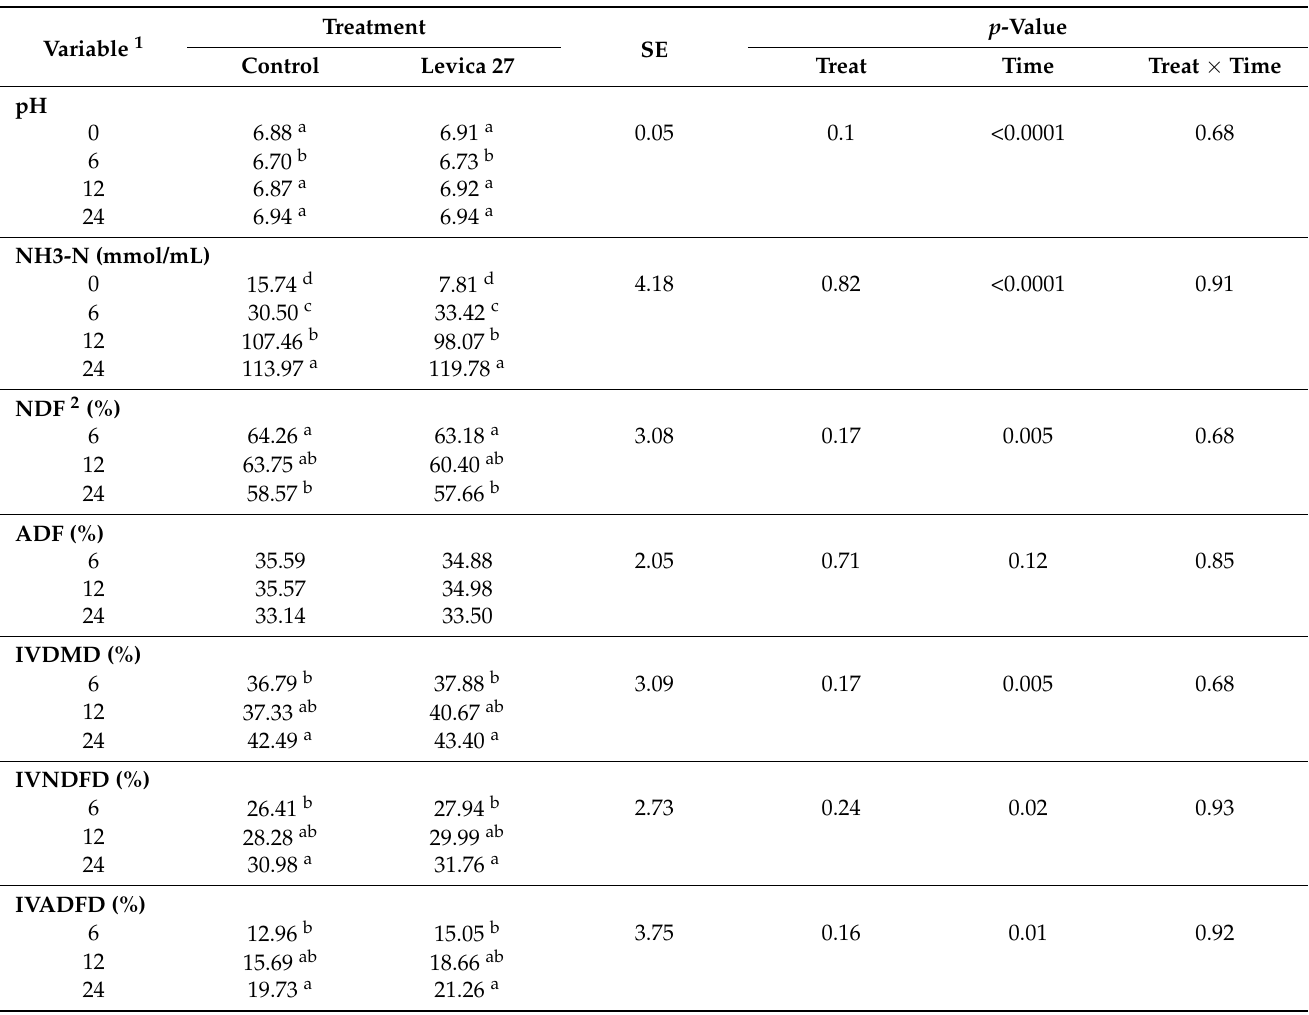
Table 2. Effect of Pichia guilliermondii strain Levica 27 on the in vitro ruminal fermentation of corn